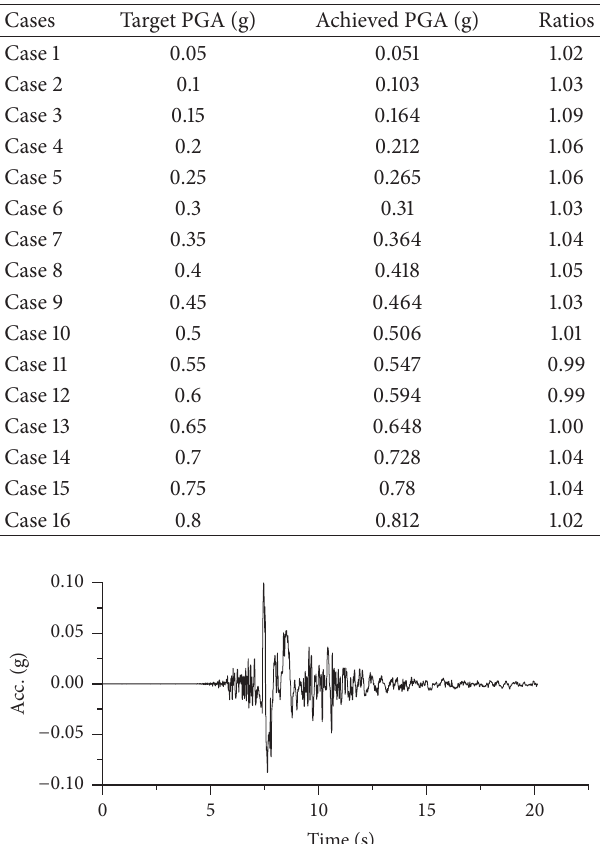
Figure 6: Input motions with compressed time axis and scaled